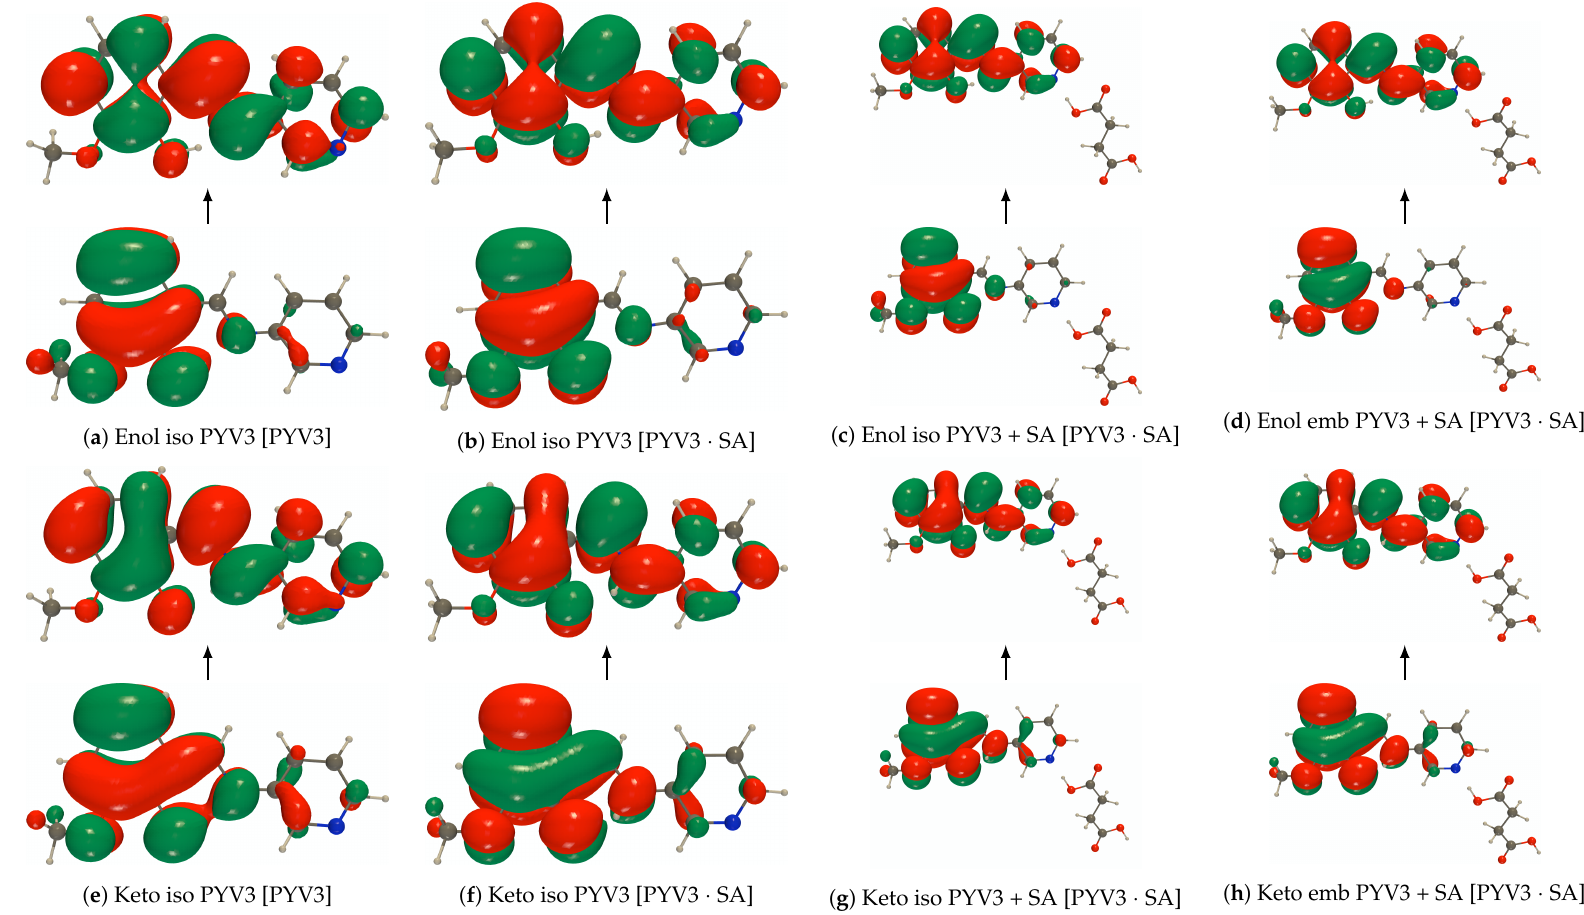
Figure 7. RI-CC2/def2-TZVPD NTOs (holes below the arrows and particles above them, the red (green) lobes are the positive (negative) ones) of the first excited state of isolated PYV3 [PYV3] and the various models of PYV3 · SA (isovalue of 0.02a.u.). “Iso” stands for isolated while “emb" for embedded in crystal field